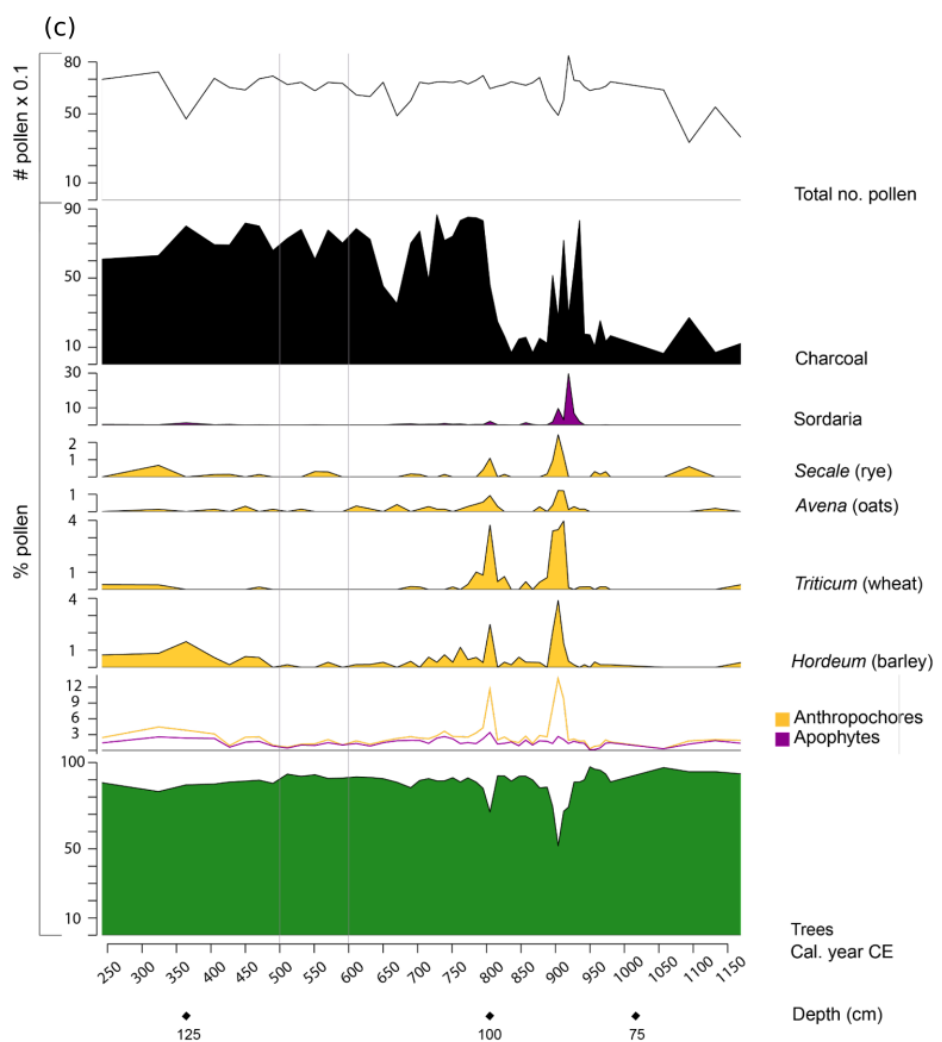
Figure 8. Pollen diagrams for (a) Ulberg (Fron area), (b) Åsheim (Høgsfjorden area), and (c) Haraldstadmyr (Sarpsborg